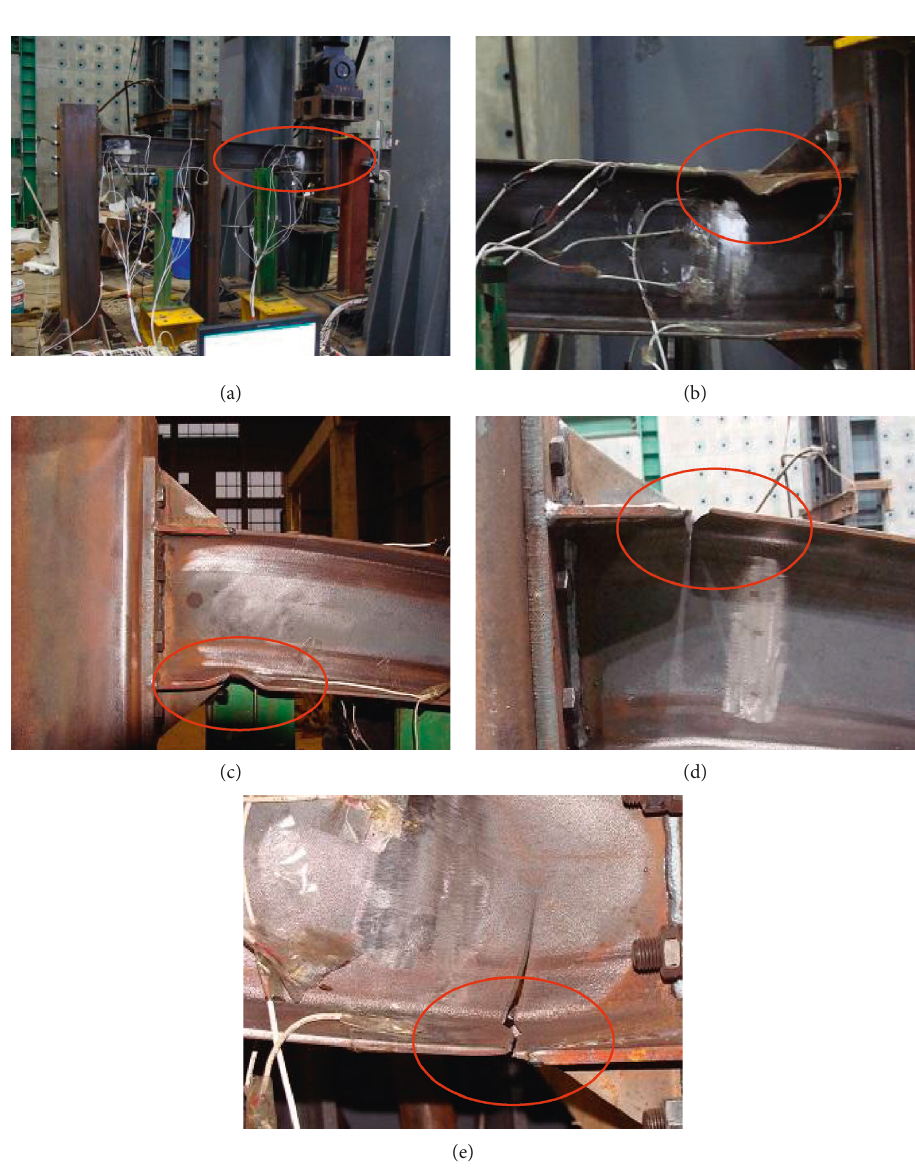
Figure 3: Failure modes of the CFSTSBF. (a) Top flange buckling in the HMR. (b) Bottom flange buckling in the SMR. (c) Top flange buckling in the HMR. (d) Top flange fracture in the SMR. (e) Bottom flange fracture in the